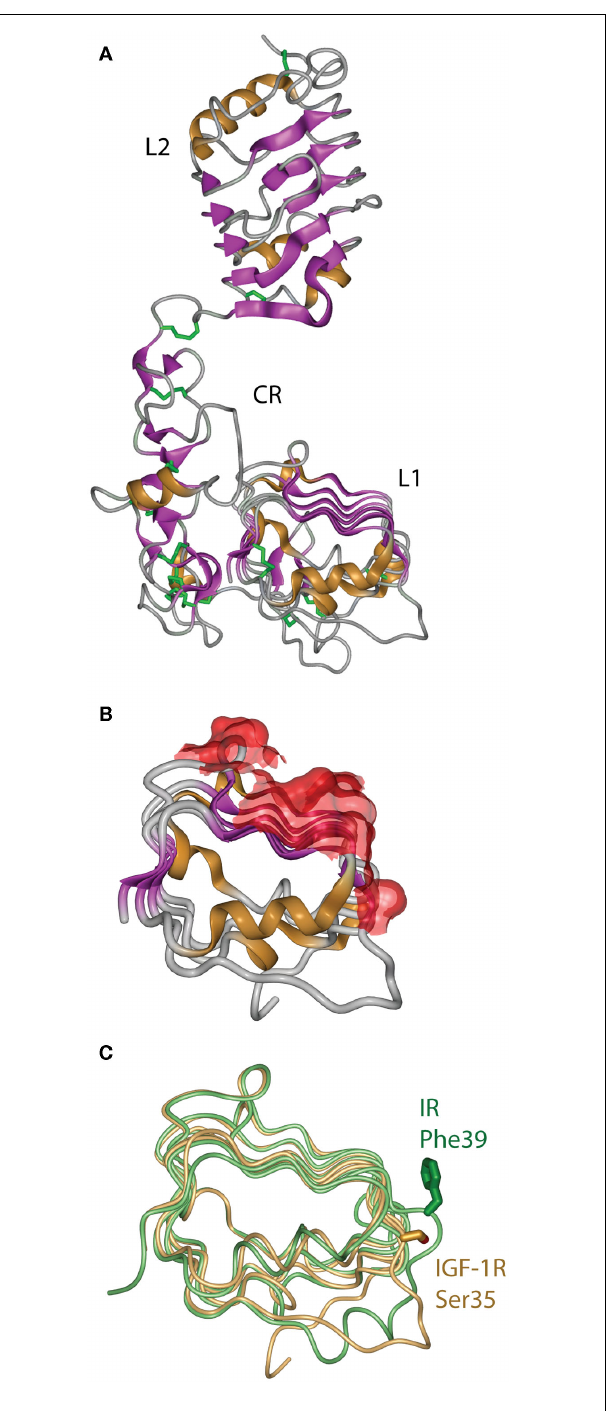
FIGURE 5 | (A) Three-dimensional crystal structure of the L1–CR–L2 module of theType 1 insulin-like growth factor receptor (IGF-1R). (B) View of the molecular surface of the central and third β -sheet of the L1 domain of IGF-1R, highlighting in red those portions of the surface that correspond to equivalent residues within the insulin receptor that have been implicated in hormone binding. (C) Overlay of the L1 domains of insulin receptor (light green) and IGF-1R (light orange), highlighting the difference in side chain disposition of the equivalent residues IR Phe39 and IGF-1R Ser35. Panels are based on PDB entries 1IGR and